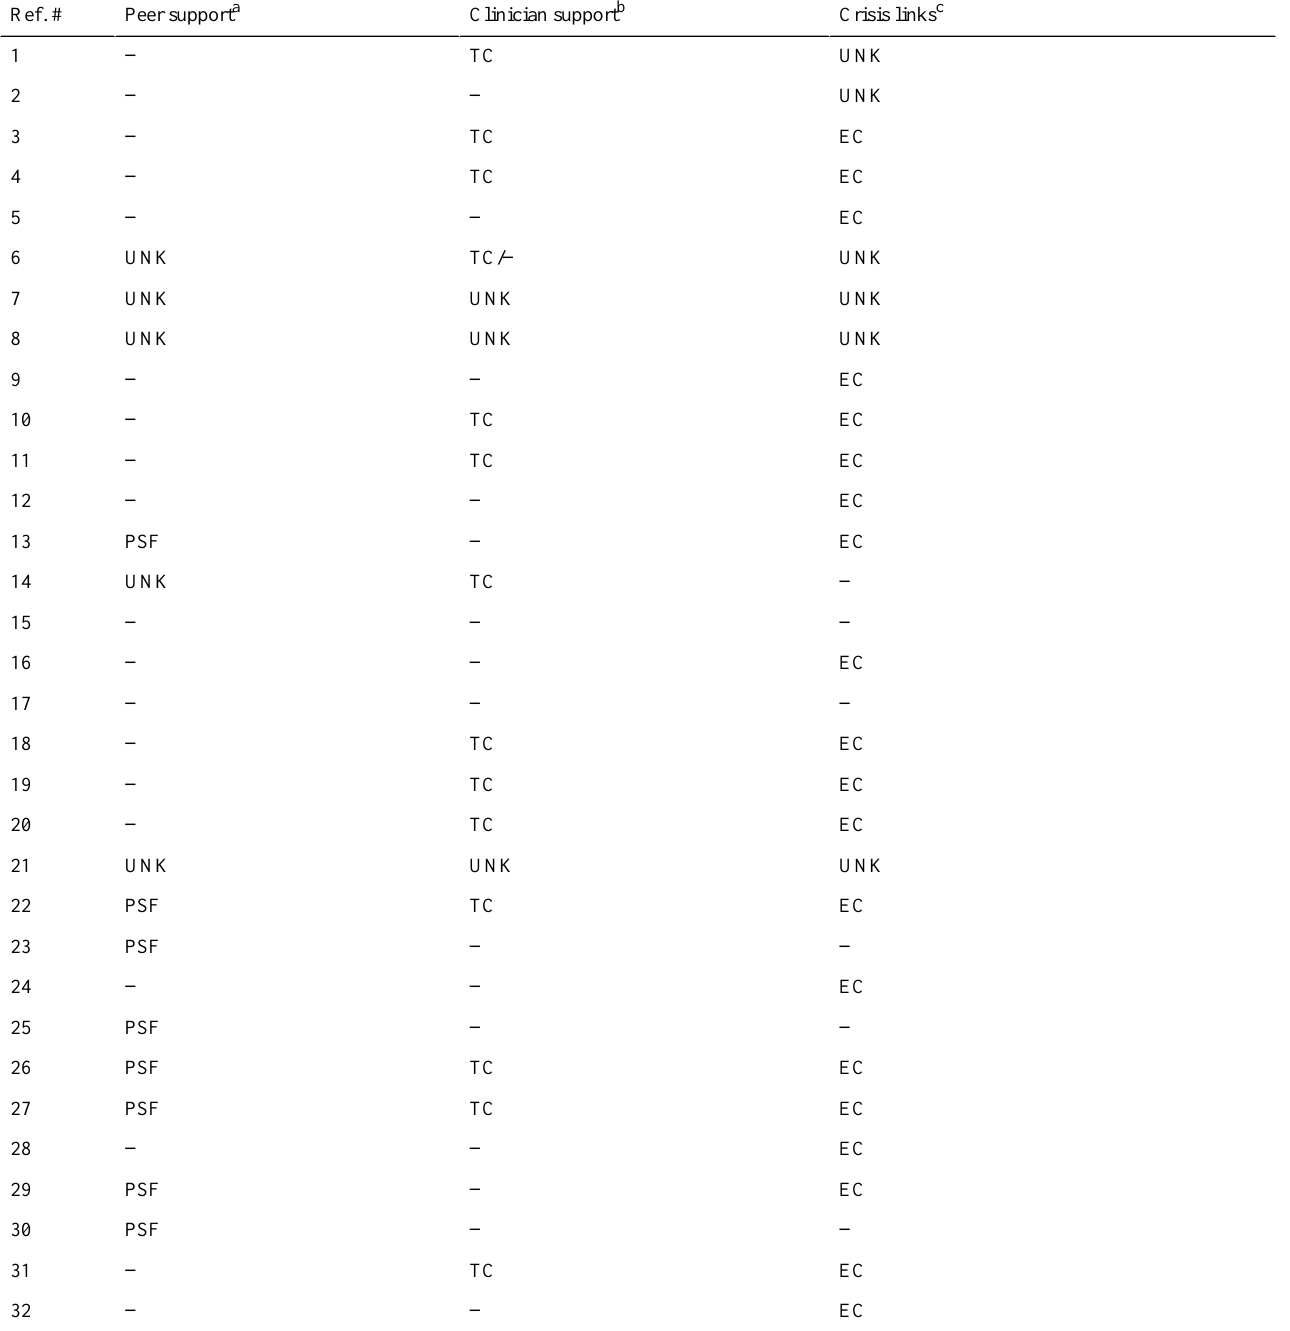
Table 5. Support associated with the programs